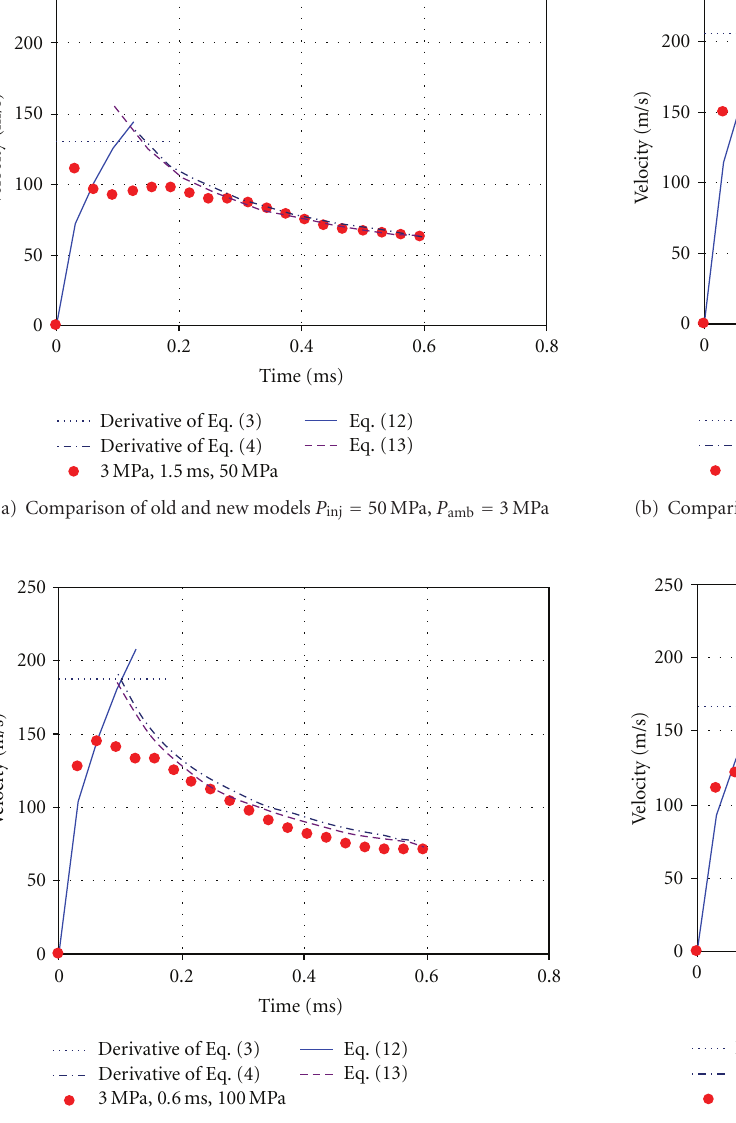
(c) Comparison of old and new models P inj = 100MPa, P amb = 3MPa (d) Comparison of old and new models P inj = 80MPa, P amb = 3MPa Figure 14: Spray velocity profiles, old and new models, Nozzle